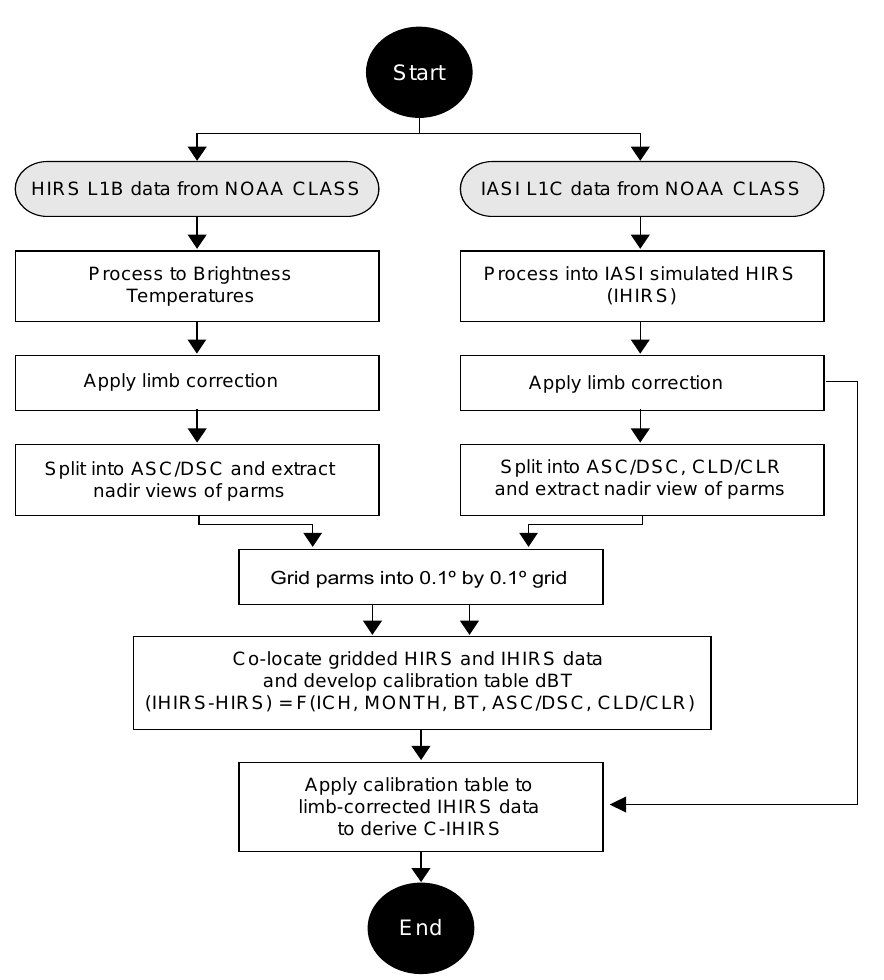
Figure 3. Flowchart depicting steps in deriving C-IHIRS data. Acronyms ASC, DSC, CLD, and CLR represent ascending, descending, cloudy, and clear respectively. Parameters “parms” include brightness temperature and cloud conditions.